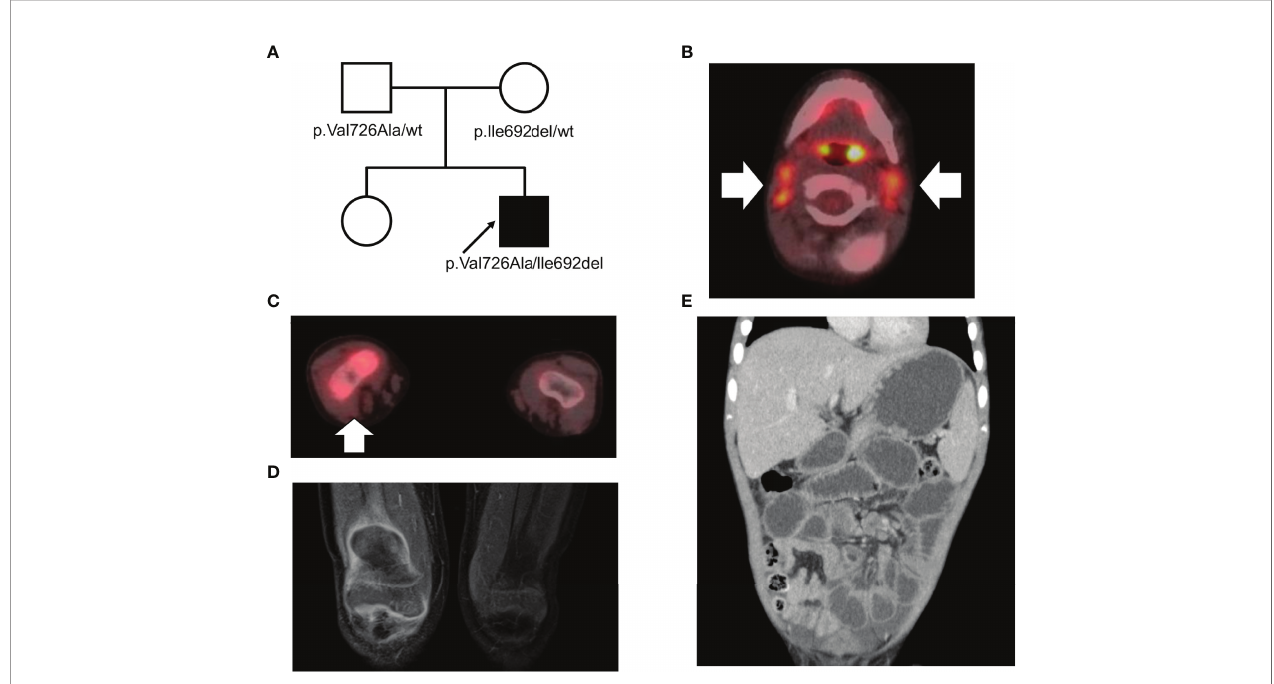
FIGURE 1 | (A) A pedigree of the family. The arrow indicates the proband. (B, C) Positron emission tomography with computed tomography scanning in (B) the cervical lymph nodes and (C) the right knee joint. (D) Contrast-enhanced magnetic resonance imaging of the synovium of the right knee joint in T1 weighted image. (E) Computed tomography scan of the